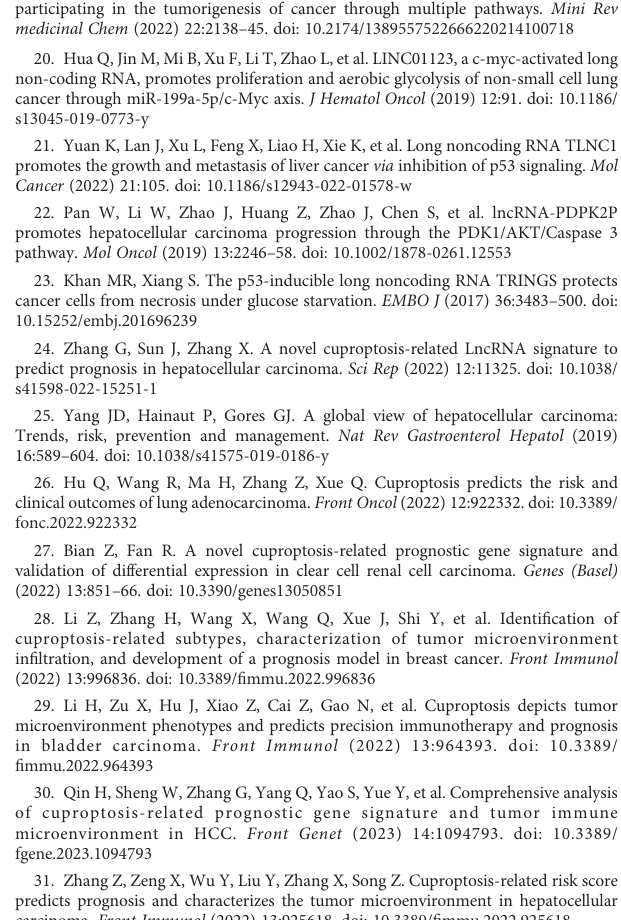
SUPPLEMENTARY FIGURE 1 Potential drug prediction. Boxplot showing the mean differences in